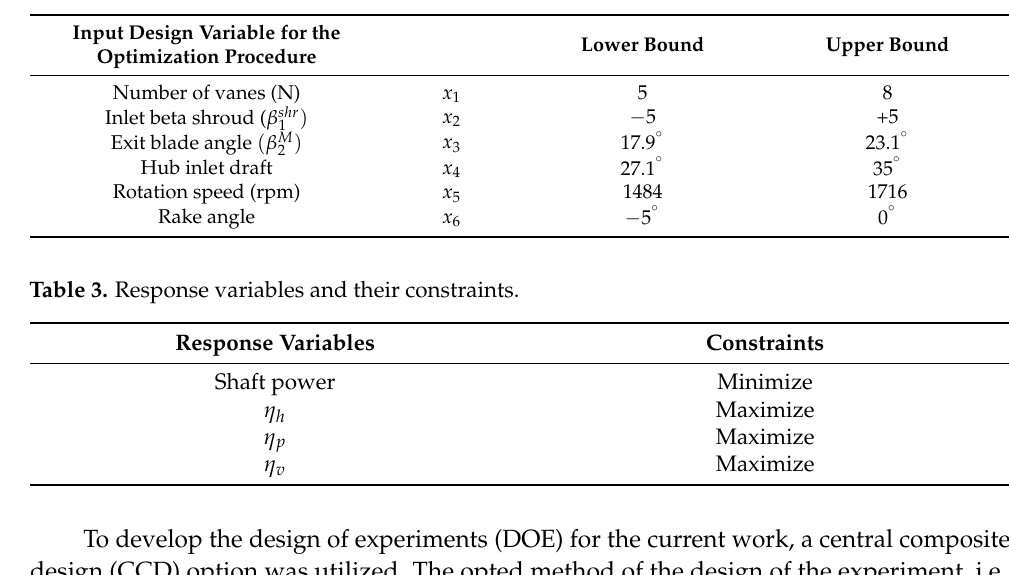
Table 2. Design variables used for the current work with their lower and upper bound limits.